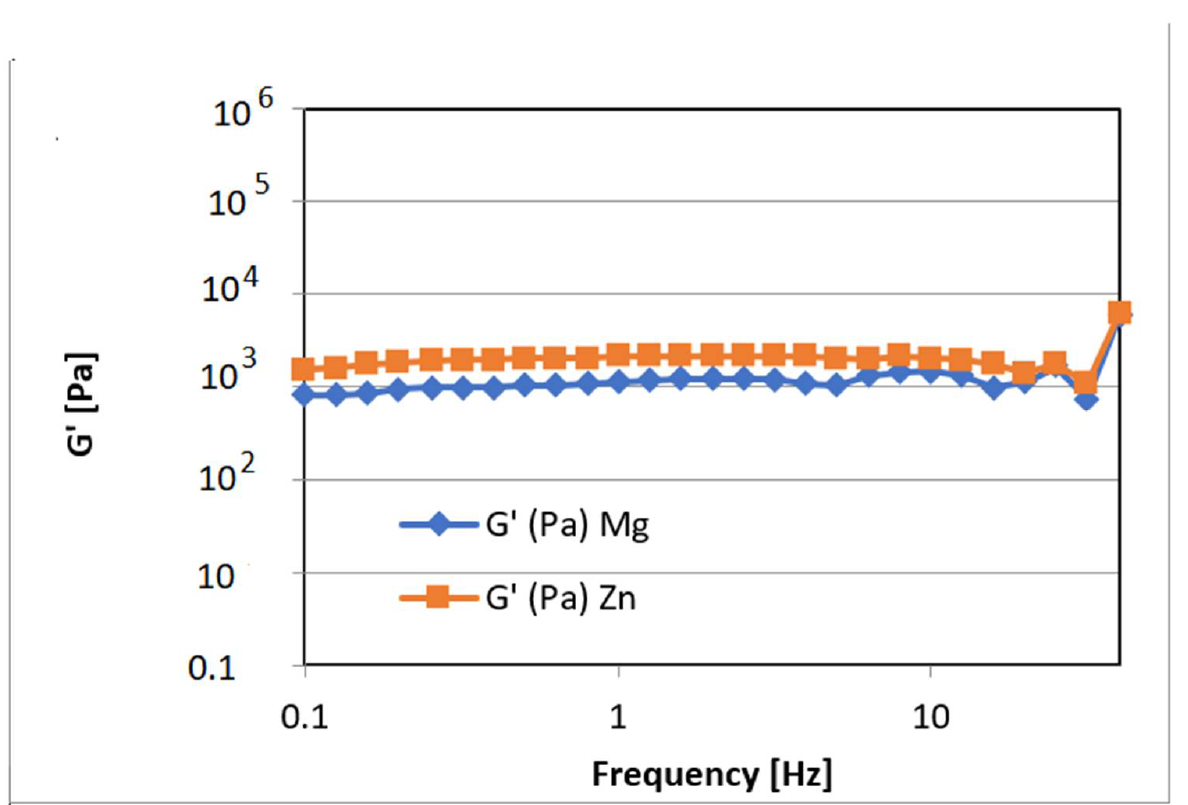
Figure 12. Storage and loss moduli of the GelMA-inorganic filler ((I)—HA doped with magnesium ions and (II)—HA doped with zinc ions) determined by the nanoindentation technique. Statistical significance: **** p < 0.0001.